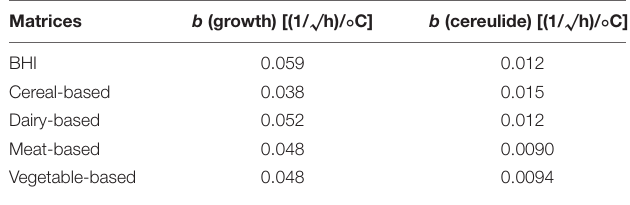
TABLE 5 | Estimates of the b -parameters of Ratkowsky, for the growth and cereulide models.